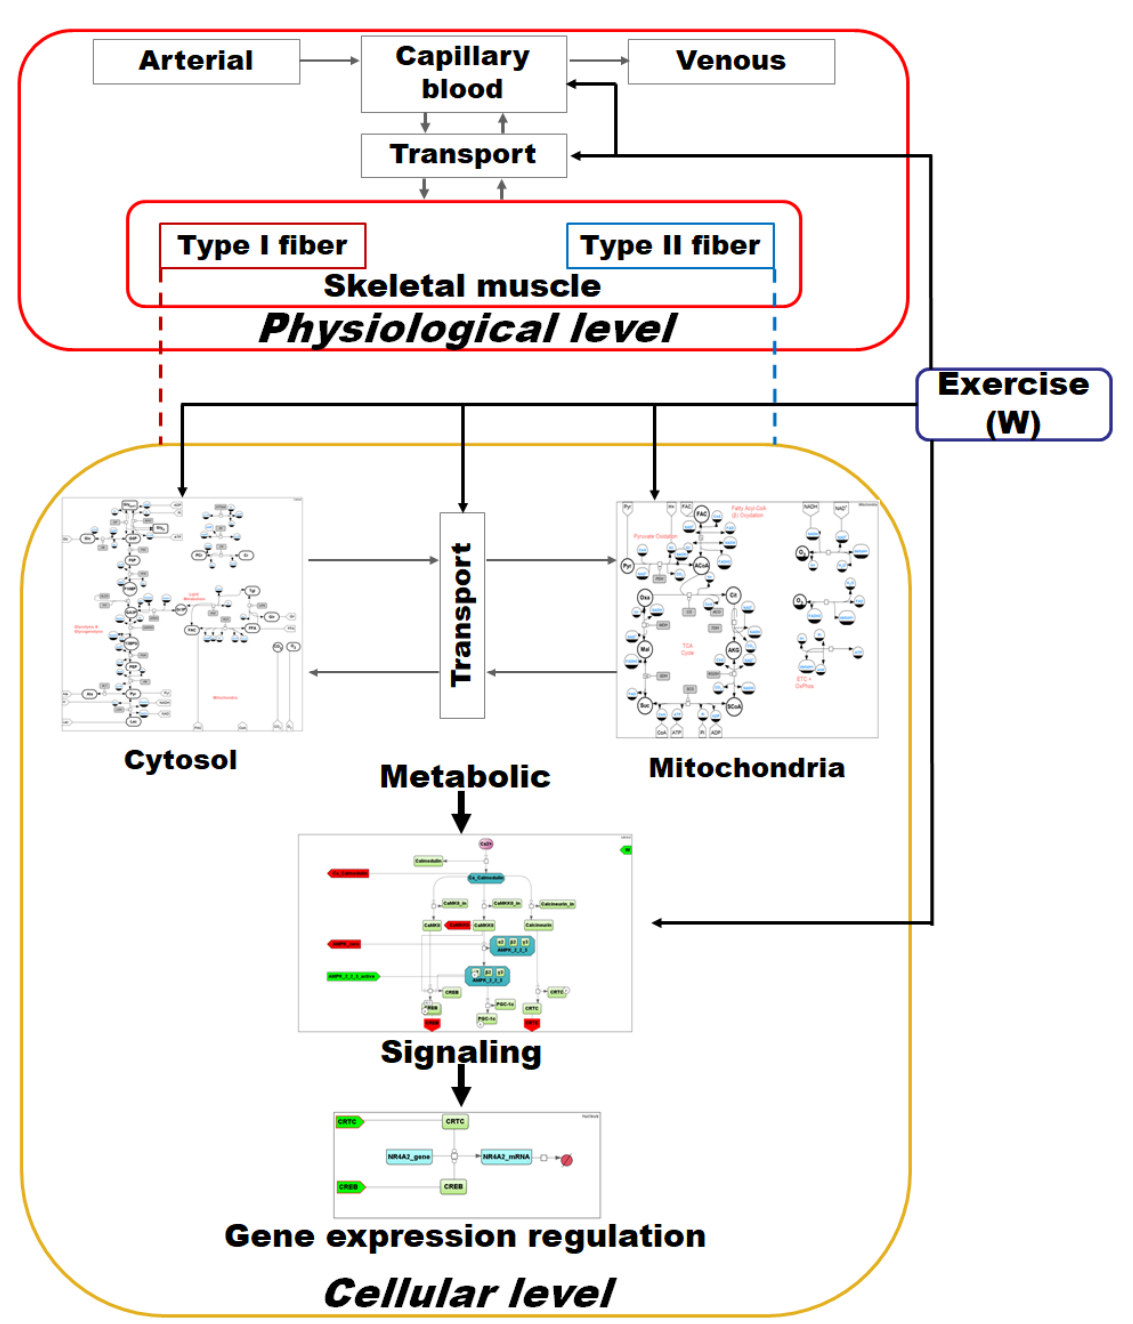
Figure 4. General structure of the integrated modular model linking metabolism, Ca 2+ -dependent signaling transduction, and regulation of gene expression in human skeletal muscle. Grey arrows on the physiological and cellular levels represent transport reactions, red and blue dashed lines from each fiber type to the cellular level indicate duplicated submodules for the corresponding fiber type, while black arrows indicate activation mechanisms related to an exercise response in the corresponding module. The metabolic sublevel consists of submodules “Cytosol” and “Mitochondria”, which in turn contain equations describing enzymatic reactions inside the certain compartment as well as of the Transport submodule comprising transport reactions between them. The signaling sublevel includes Ca 2+ - and AMPK-dependent signaling pathways, while the Gene expression regulation sublevel incorporates submodules describing the expression regulation of genes with early and delayed responses. For a detailed description of all modules and diagrams, see the Supplementary Material.